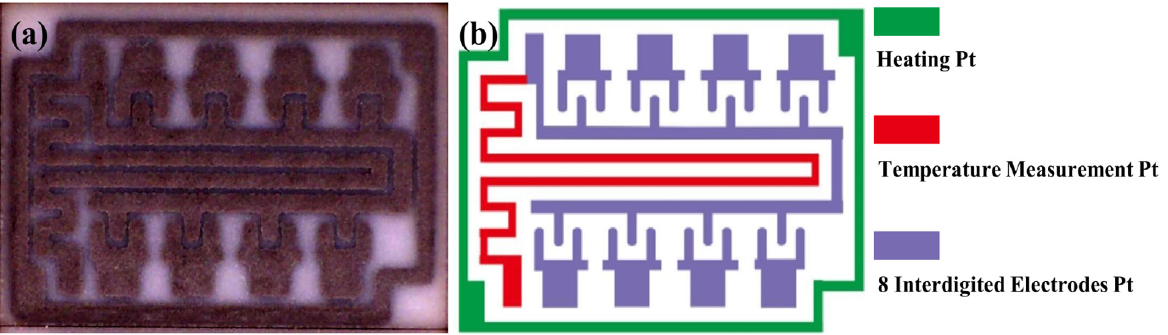
Figure 1. ( a ) Photograph of the substrate. ( b ) Structure of the Pt electrode. The chemical reagents used in this study and their concentrations are shown in Table 1.